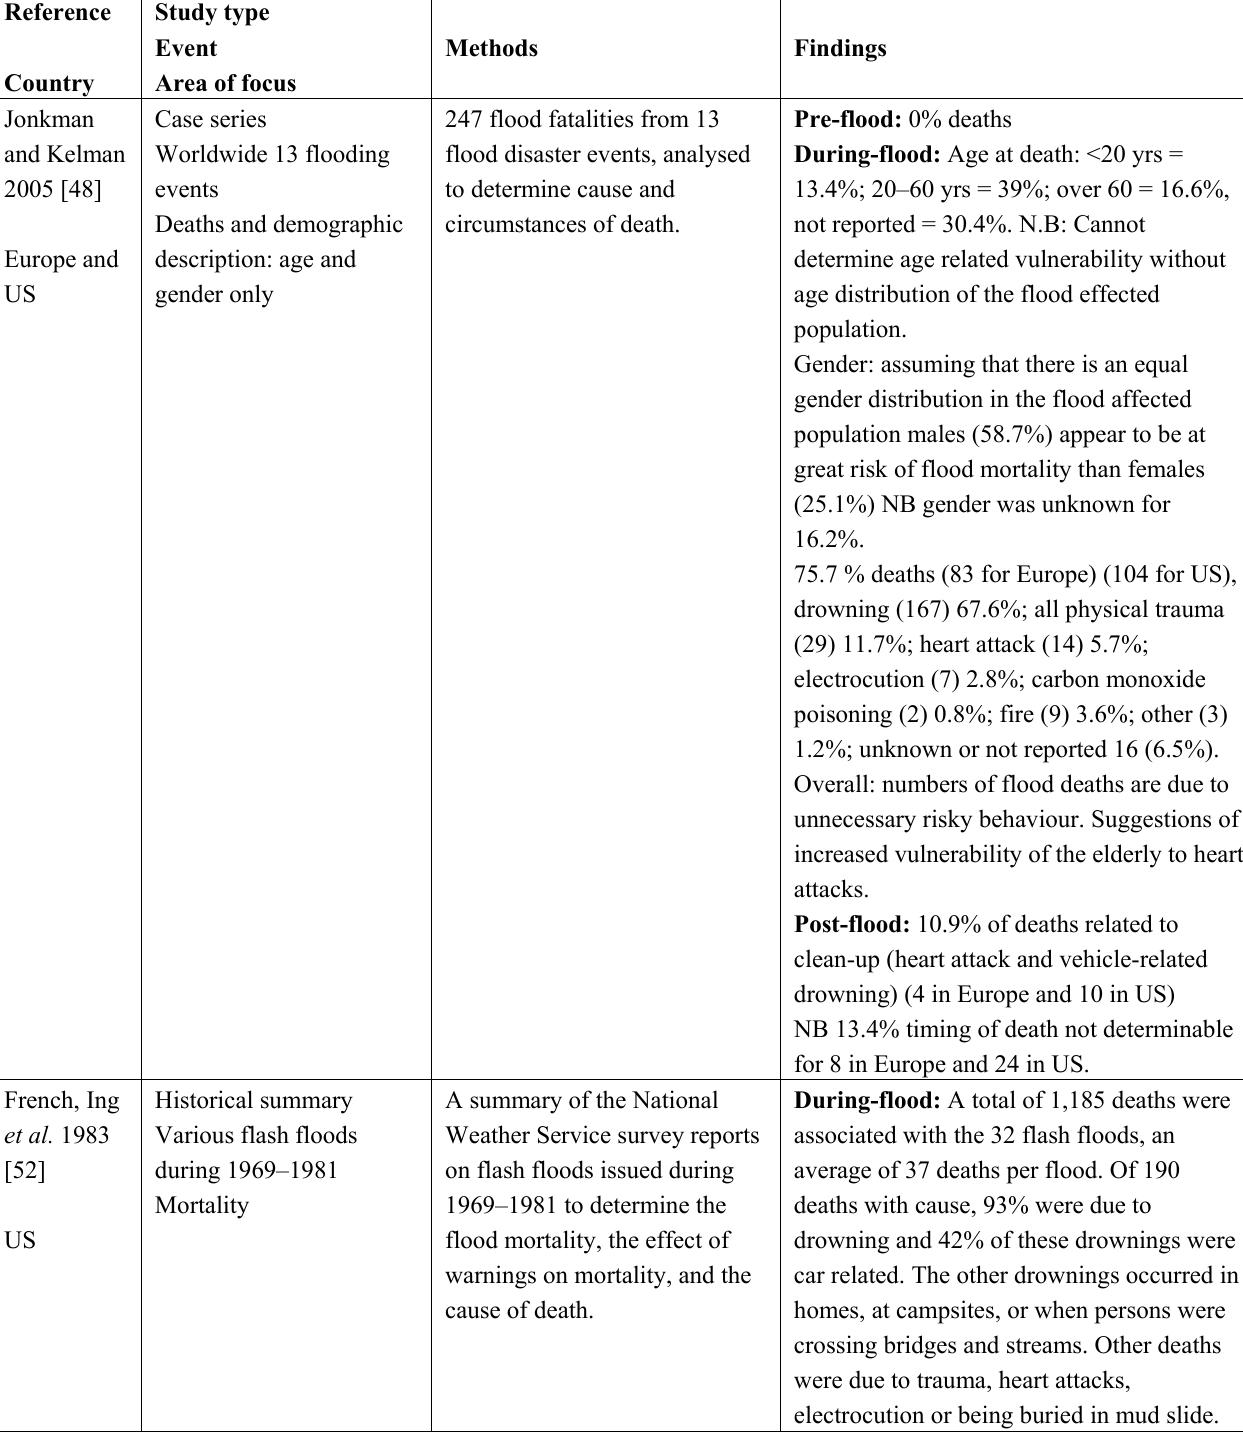
Table A4. Studies addressing research Question 3b: What are the characteristics of individuals who have experienced flood-related morbidity or mortality, without reference to source